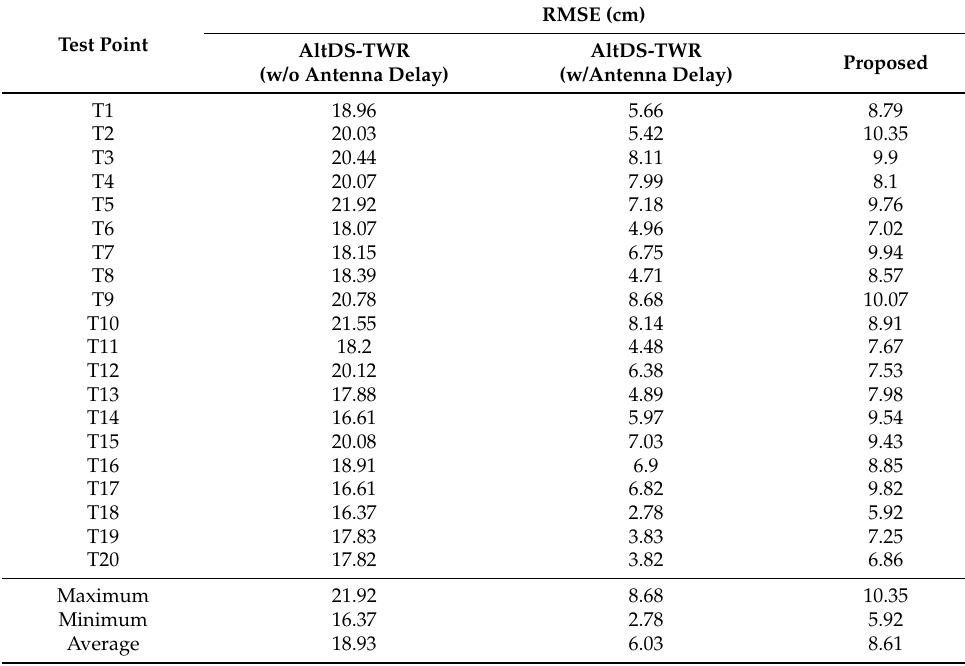
Table 2. RMSEs comparison of the estimated ranges from AltDS-TWR (w/o Antenna Delay), AltDS- TWR (w/Antenna Delay), and proposed scheme.